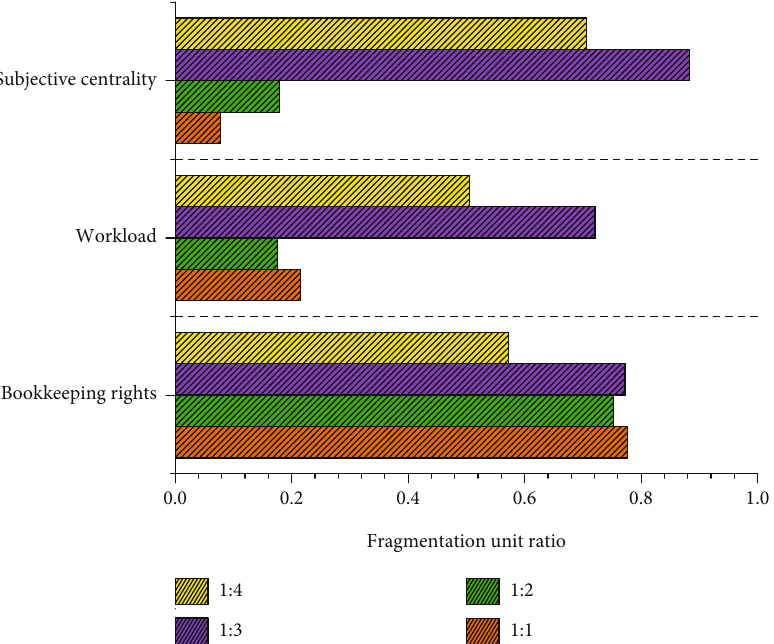
Figure 2: Variation of parameters and discrete feature shares under centralization.